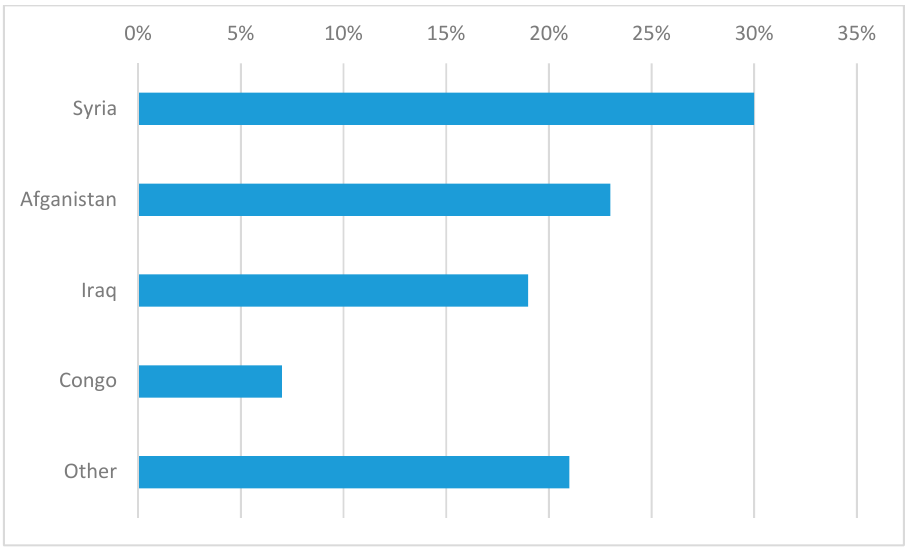
Figure 3. Demographic elements of the refugees arriving on Lesvos island.